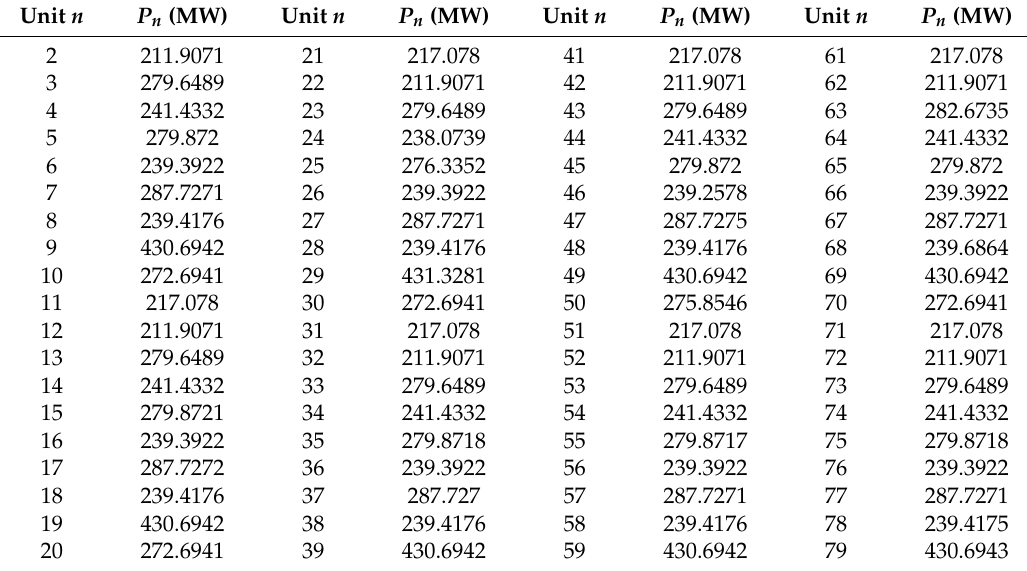
Table A4. The best decision variables for system 4 found by the proposed